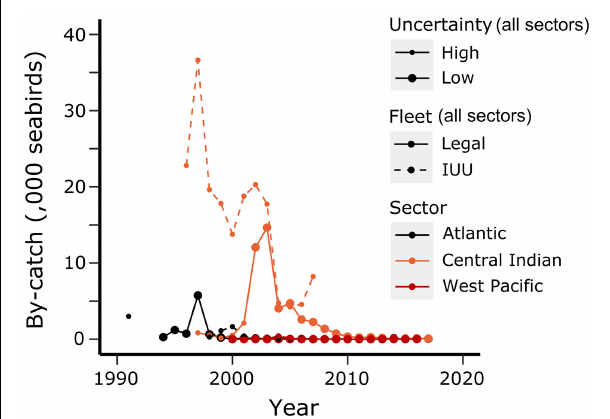
FIGURE 11 | Incidental mortality of seabirds estimated for trawl and longline fisheries (legal fleet; solid lines) and for illegal, unreported and unregulated fishing fisheries (IUU fleet; dashed lines) for each sector of the Southern Ocean (see Figure 2 ). Few birds are caught in the Antarctic Zone. Most are caught near to subantarctic islands. Data obtained from reports of the Scientific Committee of CCAMLR from 1994 to the present. Size of circle reflects the uncertainty in the estimates. Small circles reflect greater uncertainty – in IUU estimates these were labelled by SC-CAMLR as medians. Time-series of IUU estimates end in 2008; IUU fishing was low and vessels used gill nets and catches could not be